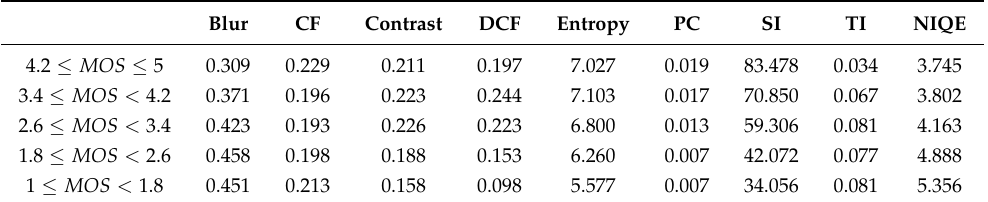
Table 8. Mean of the perceptual features in KoNViD-1k [22] with respect to different MOS intervals. In KoNViD-1k [22], the lowest possible video quality is represented by MOS = 1.0, while MOS = 5.0 stands for the highest possible video